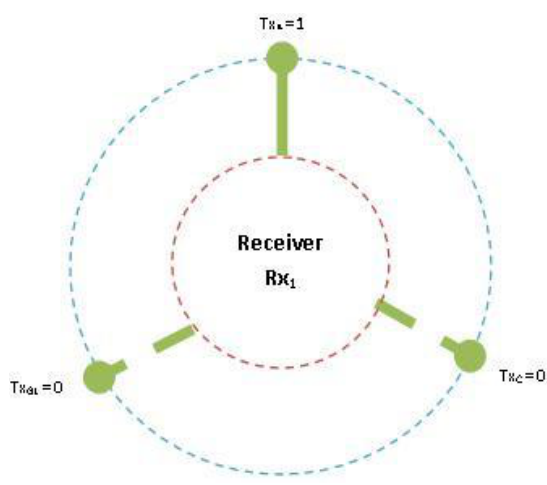
Figure 10. Radio receiving from node TXA.